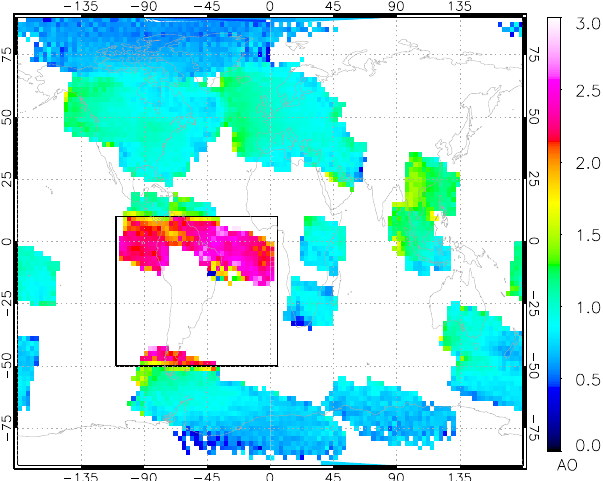
Fig. 12. The mean of the additive offset (AO) for GOME-2 for 2007 and 2008 in × 10 9 photons. The area indicated by the rectangle is affected by the South Atlantic Anomaly.